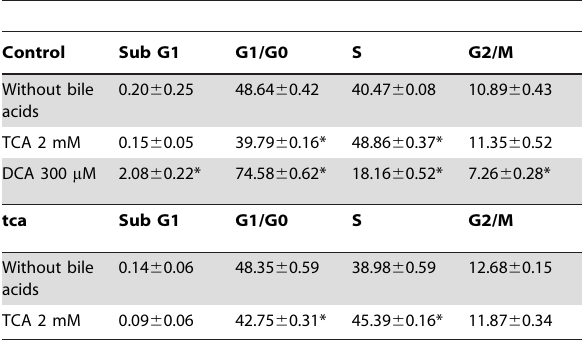
Table 1. Effects of TCA treatment on cell cycle using FACS